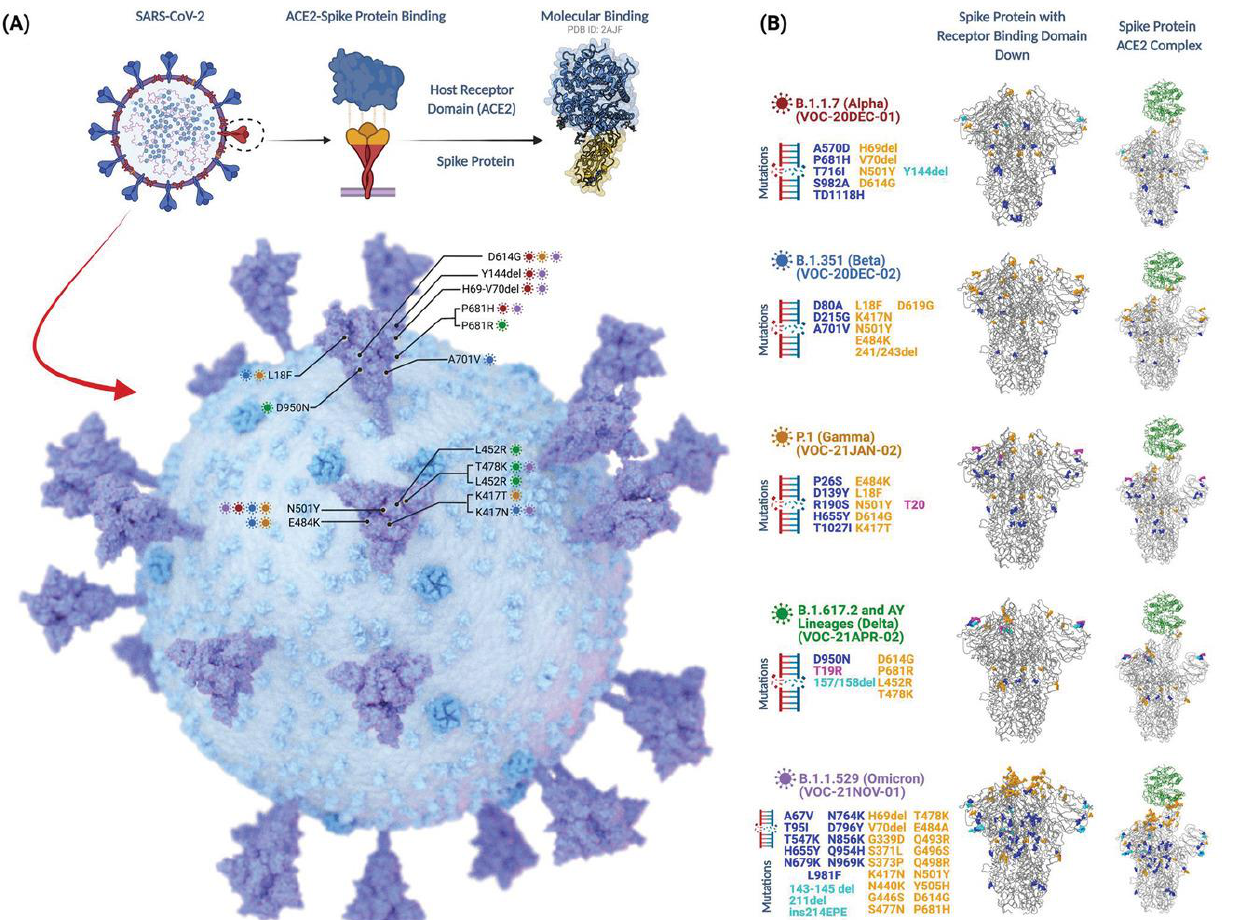
Figure 1. Summary of SARS-CoV-2 mutants/variants: ( A ) illustration of S-protein–ACE2 binding, location of the frequently detected mutations within the spike region of SARS-CoV-2; ( B ) detailed visualization of mutations that are found within the genomic structure of current VoC lineages (adopted under CC BY 4.0 License from [50]) .